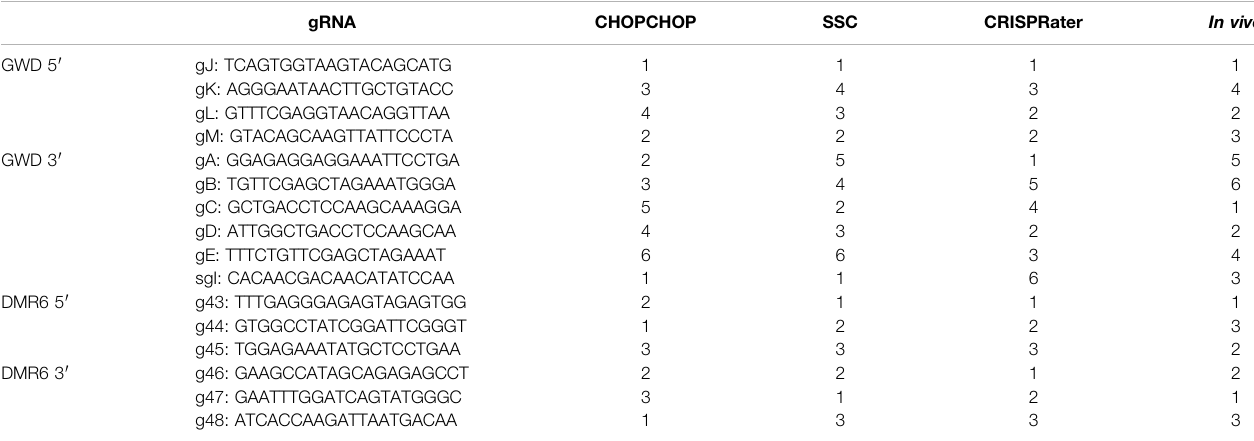
TABLE 2 | In silico scoring and in vivo editing of individual gRNAs. Ef fi ciencies grated from highest to lowest, with one being the best scoring gRNA. Scores based on the gRNA individual score in the in silico prediction servers CHOPCHOP (http://chopchop.cbu.uib.no/), CRISPRater (https://crispr.cos.uni-heidelberg.de/), SSC(http:// crispr.dfci.harvard.edu/SSC/). The in vivo score is based on editing ef fi ciencies of single RNP/gRNA transformations as evidenced by IDAA (from two to eight biological replicates were performed with std errors indicated (see also Figures 4 , 5